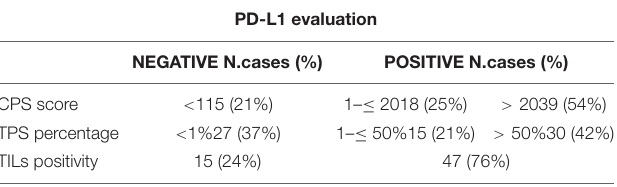
TABLE 2 | Results of the PD-L1 IHC evaluation.